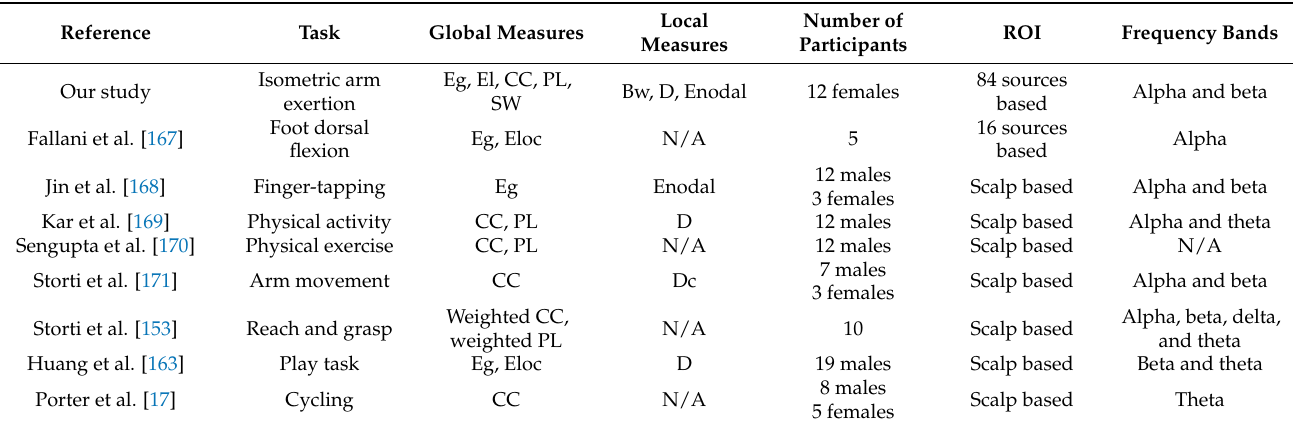
Table 11. Comparison of the proposed method’s main virtues vs. the state-of-the-art report. Bw: Betweenness centrality, PL: Characteristic path length, CC: Clustering coefficient, D: Degree, Eg: Global efficiency, Eloc: Local efficiency, Enodal: Efficiency of nodal, N/A: Not applicable, and SW: Small-world